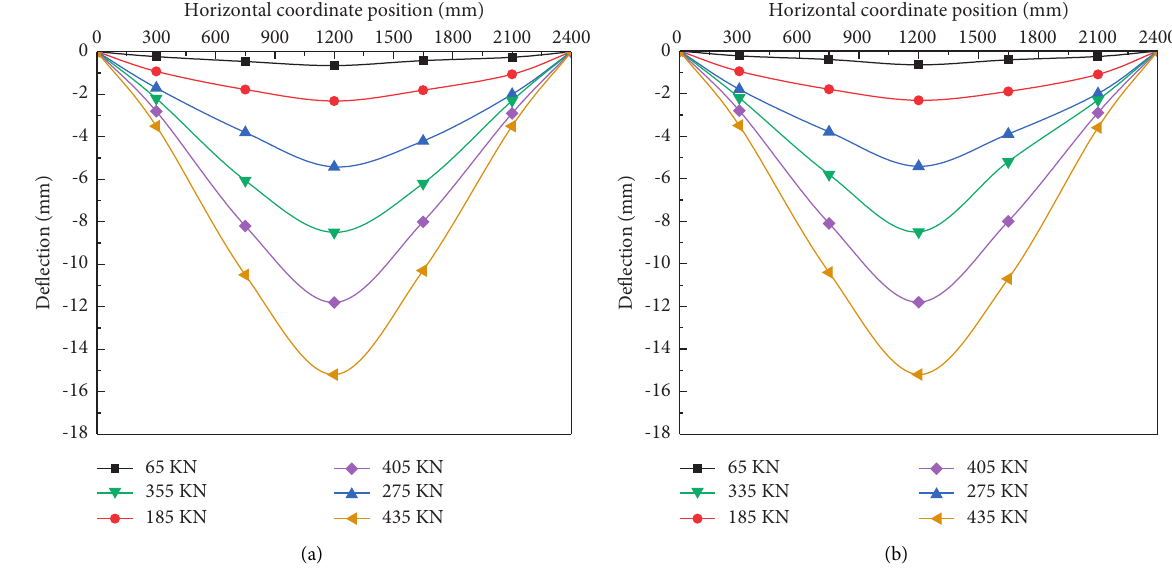
Figure 6: Deflection curves at different positions under different loads. (a) x direction. (b) y direction.